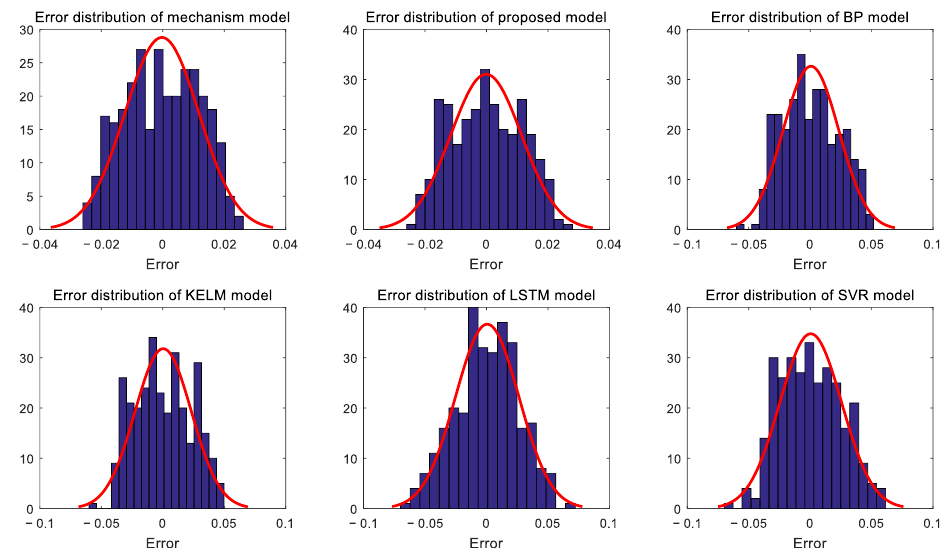
Figure 7. Error distribution of different prediction models when the data fluctuate greatly.